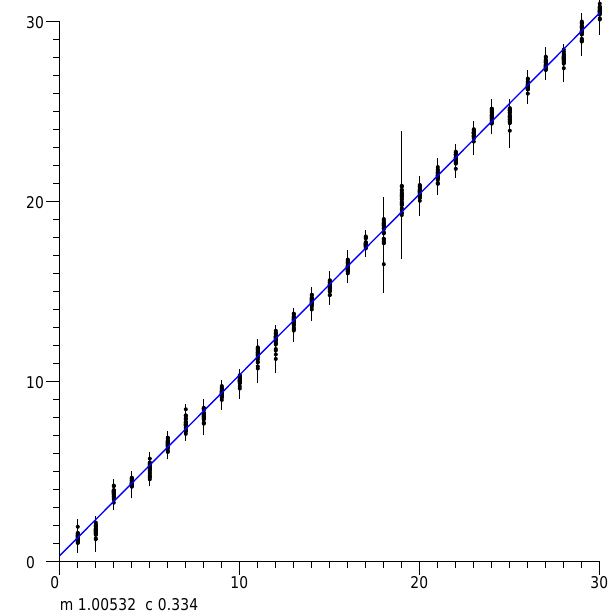
Figure 4. Linear fit of reported distance to actual distance (outdoors, clear line of sight (LOS), no obstructions in the first Fresnel zone). The offset in the well calibrated setup tested here happens to be small (less than half a meter), but can be five meters or more in other situations. Horizontal axis: actual position in meters. Vertical axis: fine time measurement (FTM) of the round trip time (RTT) reported distances in